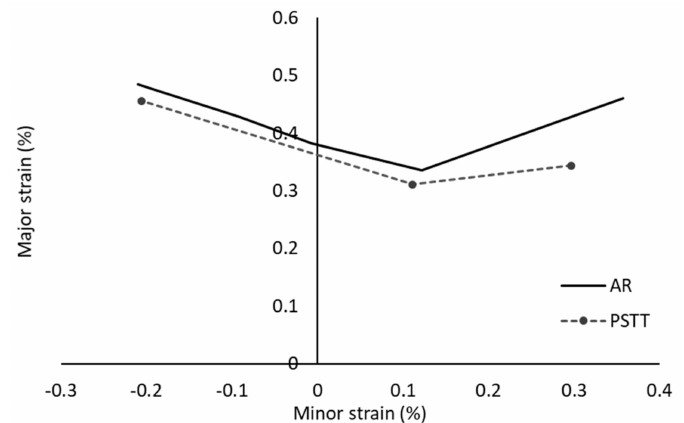
Figure 7. FLC of the Inco718 material. The continuous lines show the FLC of the AR necking limit, and the dashed lines denote the PSTT necking